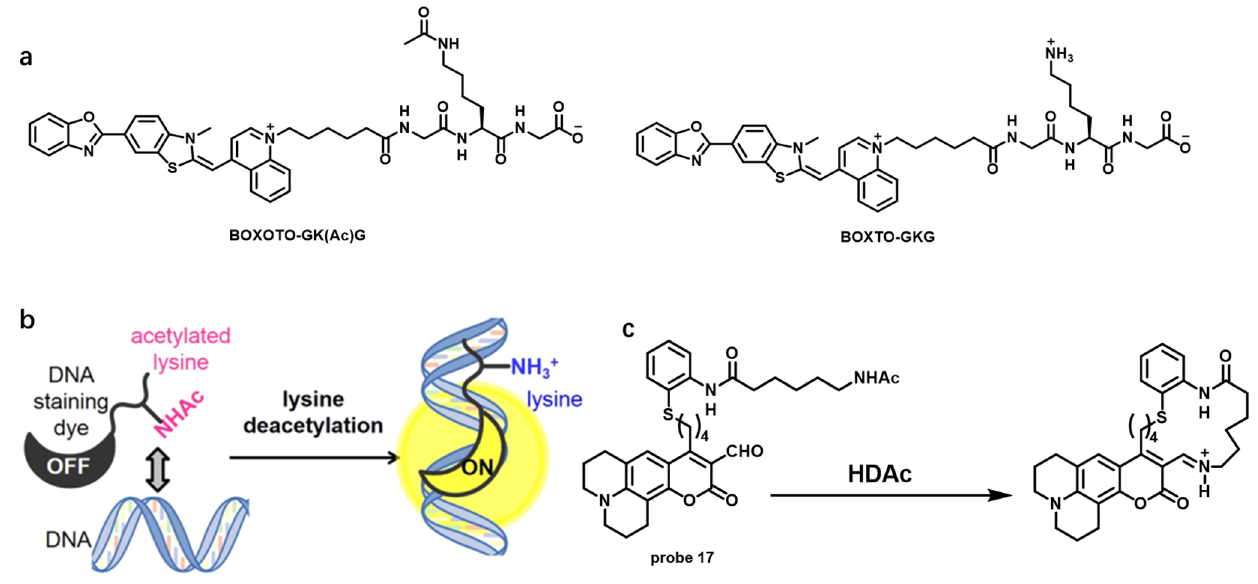
Figure 20. ( a ) Structures of BOXOTO-GK(Ac)G and BOXTO-GKG. ( b ) Schematic illustration of the HDAC detection system that uses a fluorogenic probe based on a DNA staining dye. Reproduced from [68] with permission from the American Chemical Society, Copyright 2014. ( c ) Schematic representation of probe 17 used to detect HDACs.